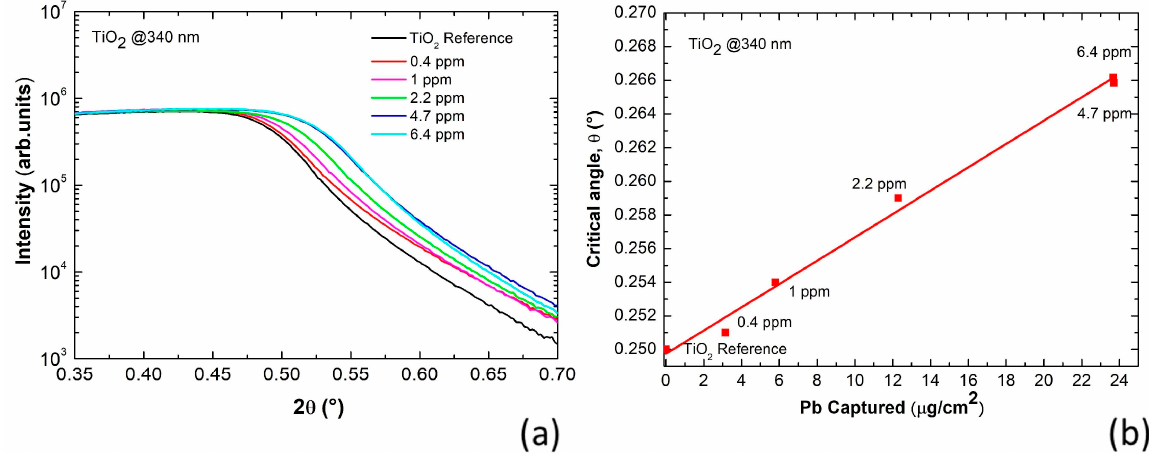
Figure 2. ( a ) XRR curves taken on gig-lox TiO 2 layers soaked into solutions at increasing Pb concentrations. The progressively increasing amount of Pb captured by the sponge causes an increase in the θ c values. A saturation is encountered at 4.7 ppm at the used sponge thickness (340 nm). ( b ) Critical angles as a function of the Pb captured by the sponge and measured by ICP-mass spectrometry. The linear fit has a slope of 6.93 × 10 − 4 (°cm 2 / μ g) and an intercept of 0.25°. Table 1. Critical angle values for pure TiO 2 and for each concentration of Pb in aqueous solutions. Sample Critical Angle, θ c ( ◦ ) w / o lead